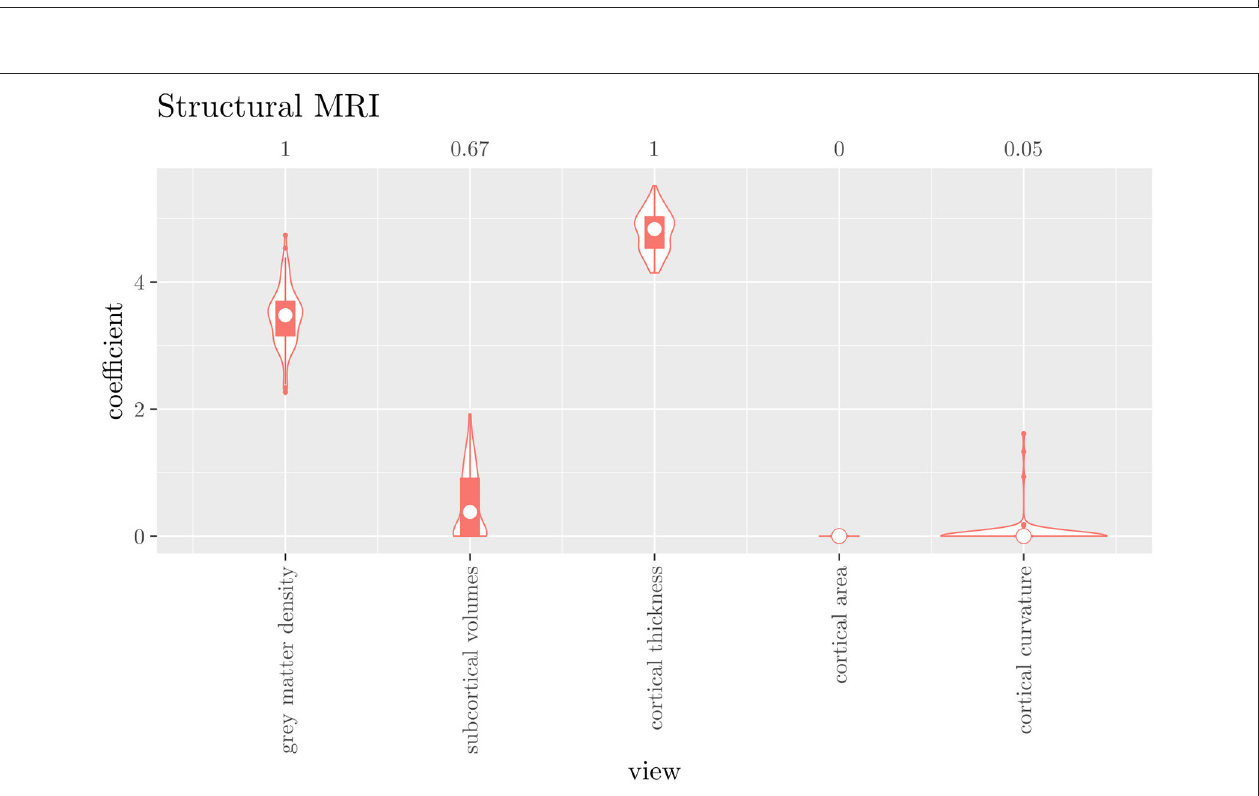
FIGURE 6 | Box-and-violin plots of the hierarchical StaPLR intermediate-level regression coefficients for the structural scan type. The numbers at the top of the graph denote the proportion of times the coefficient was nonzero.